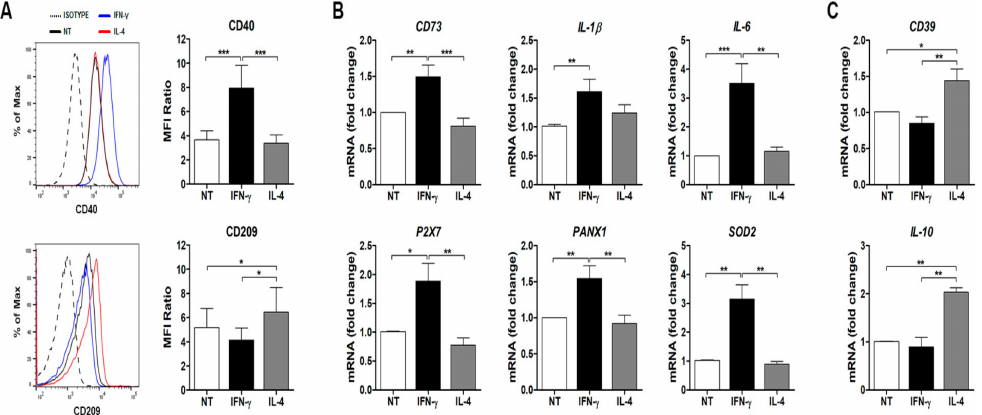
Figure 1. Characterization of the CHME-5 microglia phenotypes stimulated with IFN- γ and IL-4. ( A ) Flow cytometry analysis of CD40 and CD209 surface markers expression. Left panels show representative histogram plots comparing CD40 and CD209 expression by mean fluorescence intensity (MFI) in CHME-5 microglia cells untreated (black line) or treated for 24 h with IFN- γ (blue line) or IL-4 (red line). Right panels report the calculated MFI ratios for CD40 and CD209 expression in untreated (NT), IFN- γ , and IL-4 treated CHME-5 cells. The results represent the mean ± SEM from three independent experiments (* p < 0.05 and *** p < 0.001; one-way analysis of variance (ANOVA) followed by Bonferroni post hoc test). ( B , C ) Gene expression analysis of M1 (CD73, IL-1 β , IL-6, P2X7, PANX1, and SOD2) and M2 (CD39 and IL-10) markers by real time PCR in untreated (NT), IFN- γ , and IL-4 treated cells. Results are expressed as mean ± SEM of fold change values relative to the untreated condition (* p < 0.05, ** p < 0.01, *** p < 0.001; one-way ANOVA followed by Bonferroni post hoc